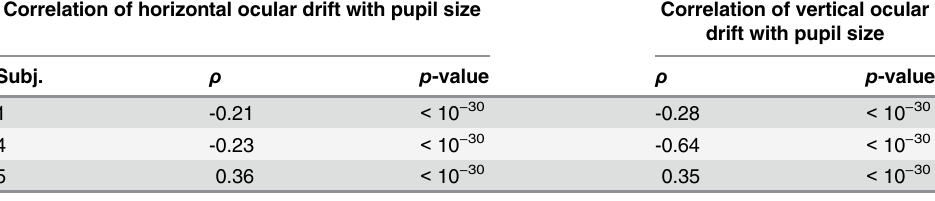
Correlations of pupil size with horizontal and vertical ocular